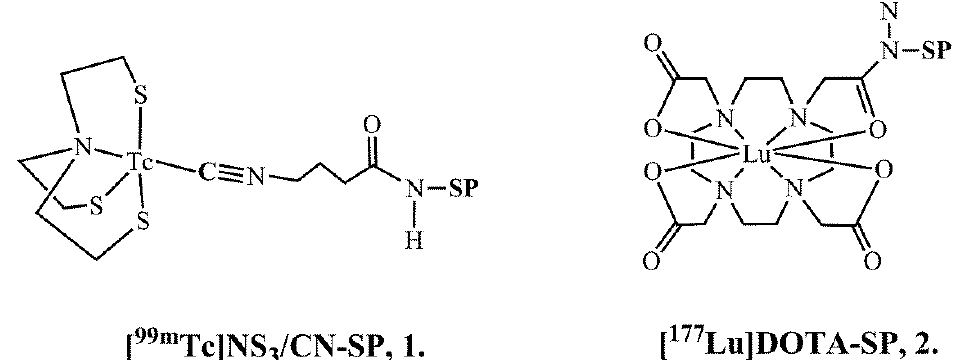
99m Tc]NS 177 Lu]DOTA-SP (2) 3 /CN-SP (1) and [